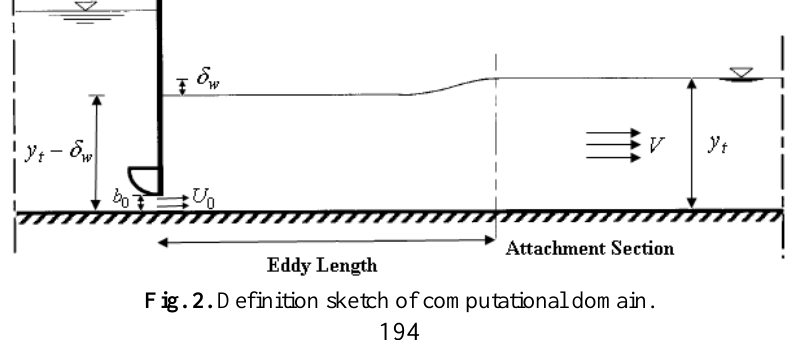
Fig. 2. Definition sketch of computational